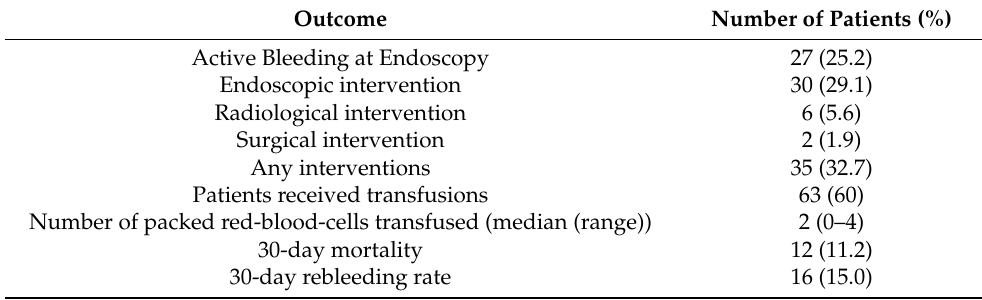
Table 2. Outcomes